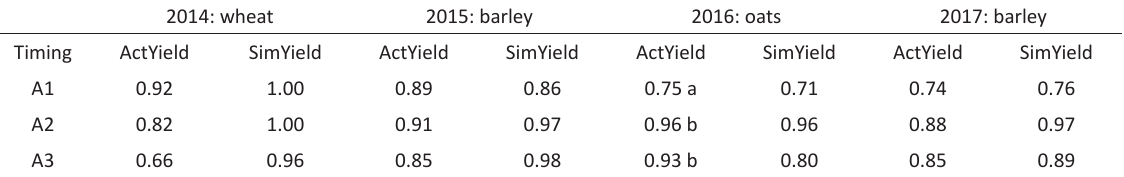
Table 5. Lsmean values of actual yield (ActYield 1 ) and simulated yield (SimYield 2 ) affected by timing (Sowing date: A1 = early, A2 = medium, A3 =